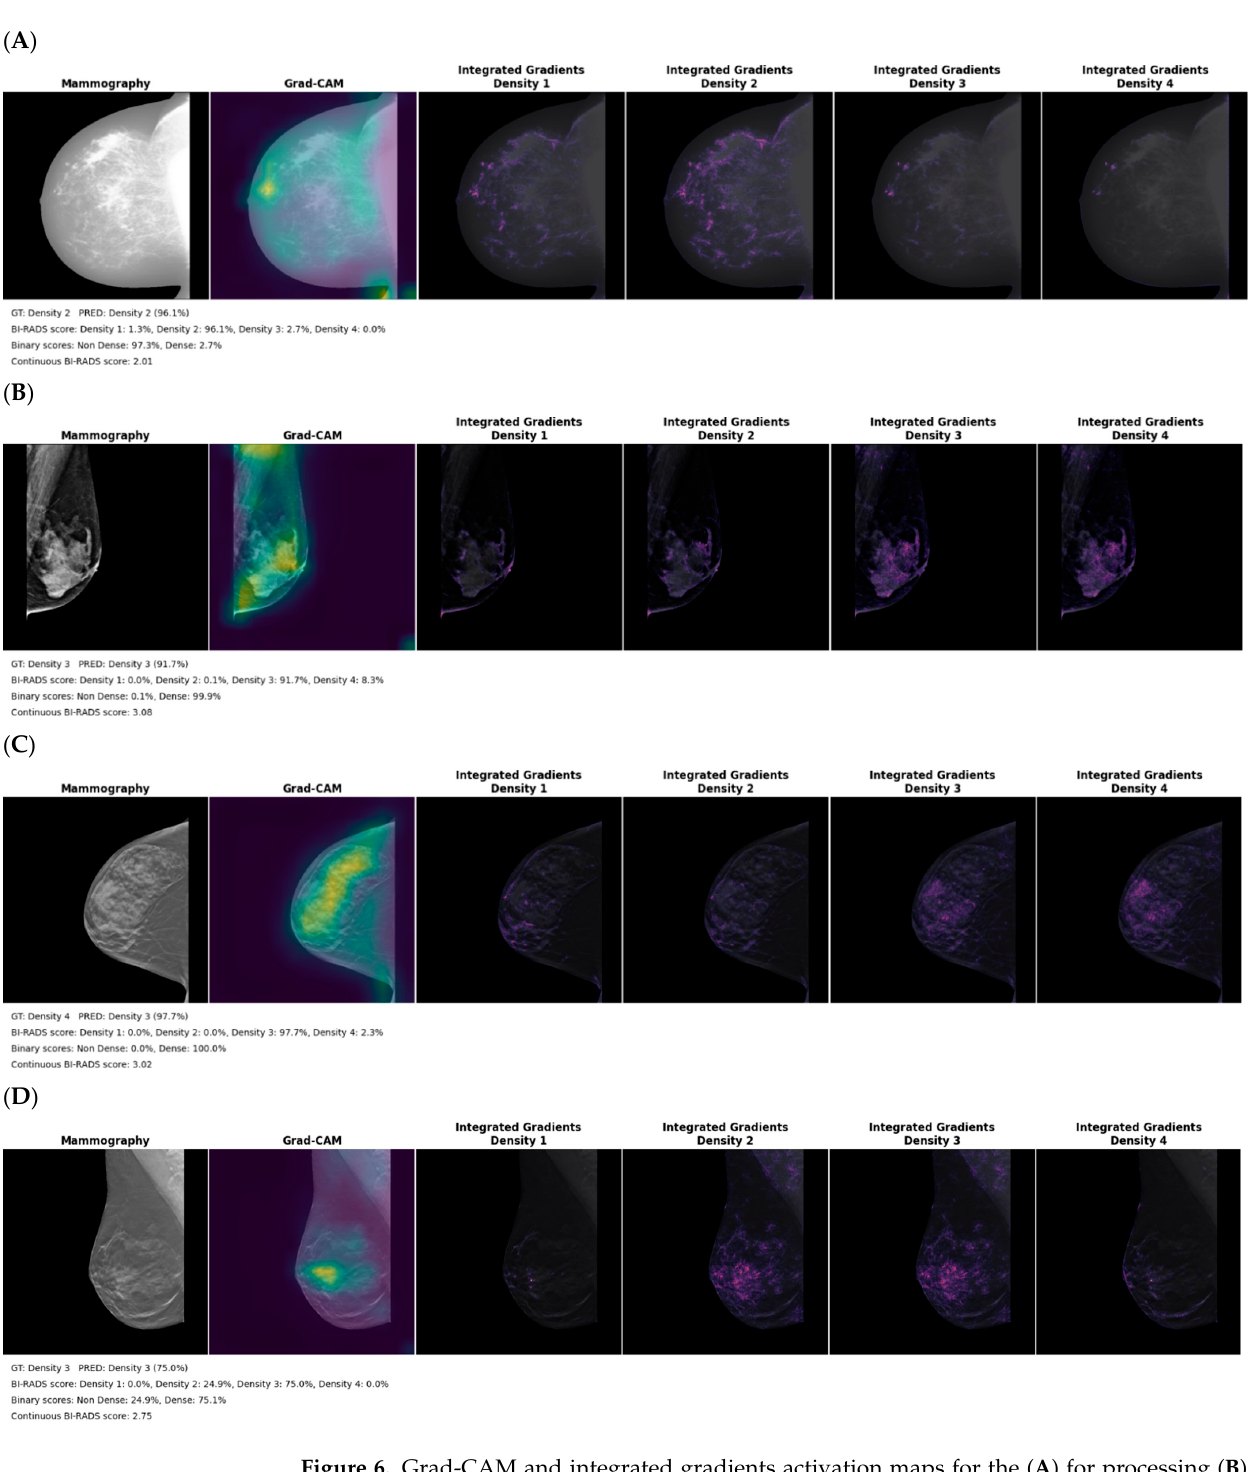
Figure 6. Grad ‐ CAM and integrated gradients activation maps for the ( A ) for processing ( B ) for presentation ( C ) synthesized 2D and ( D ) digital breast tomosynthesis mammography models on the test dataset. The legend includes the ground truth (GT) clinical reader density class, predicted (PRED) density, the probability for the 4 classes, the summed probability for binary output and the continuous BI ‐ RADS score.